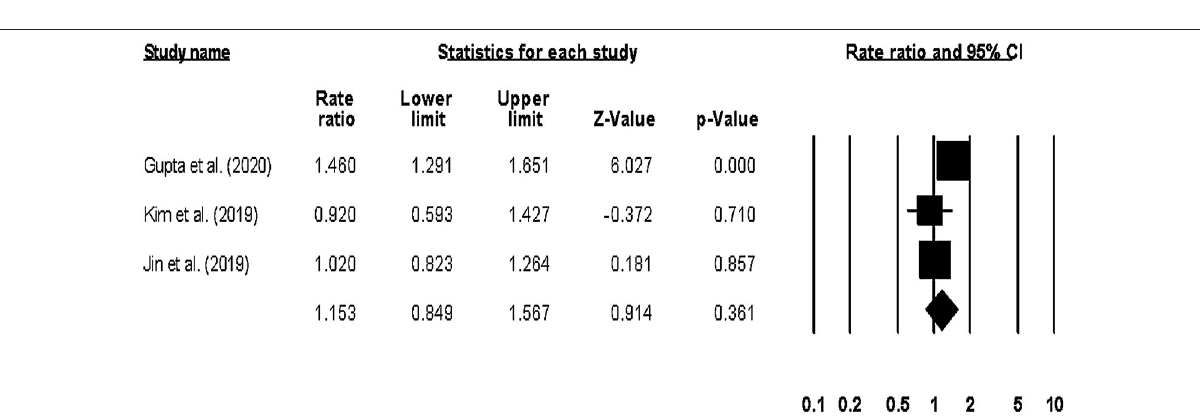
FIGURE 9 | Forest plot for studies evaluating the overall long-term hospitalization outcome. The adjusted odds ratios are presented as black boxes whereas 95% confidence intervals are presented as whiskers. A negative odds ratio represents a reduction in the risk of mortality in heart failure patients with anemia, whereas the positive odds ratio represents an increase in the risk of mortality in heart failure patients with